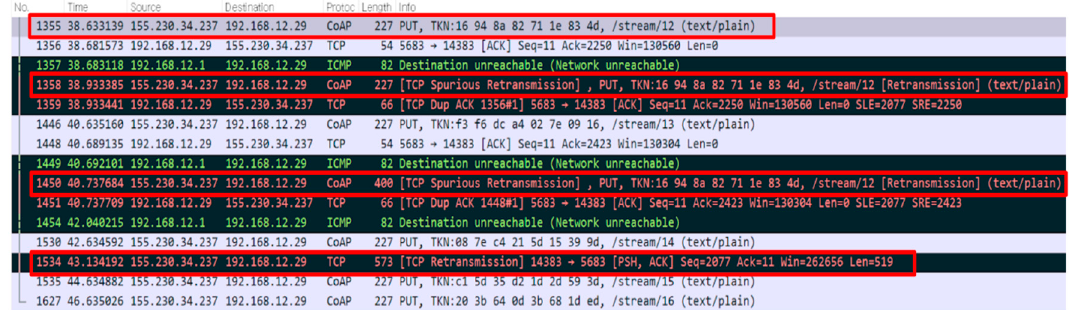
Figure 8. Drawback of TCP error handling.